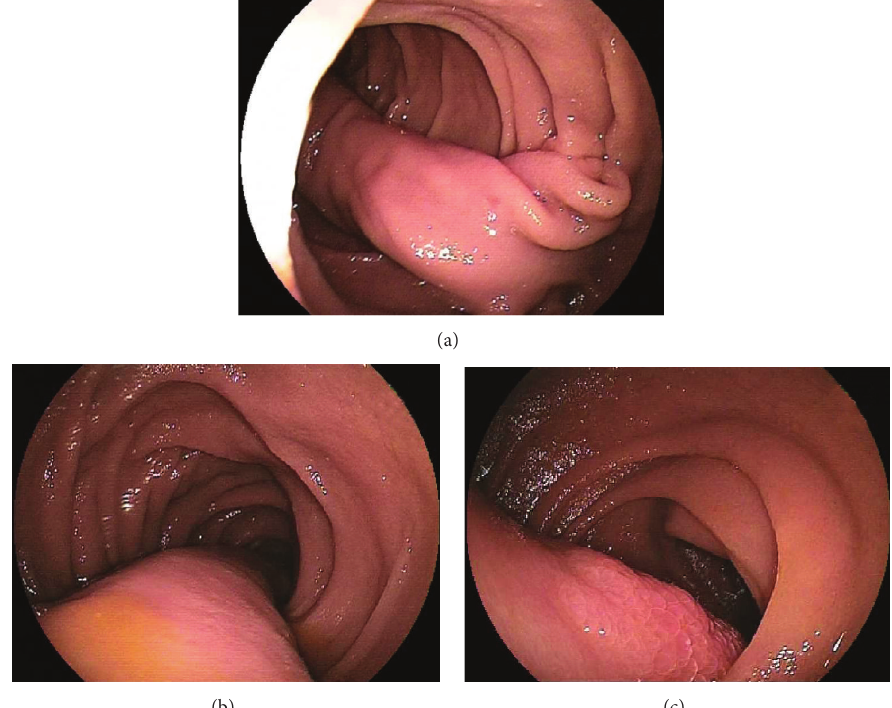
Figure 7: Fibrolipoma of the distals duodenum extends beyond oral jejunum ((a) stalk, (b) body, and (c) head of the polyp).